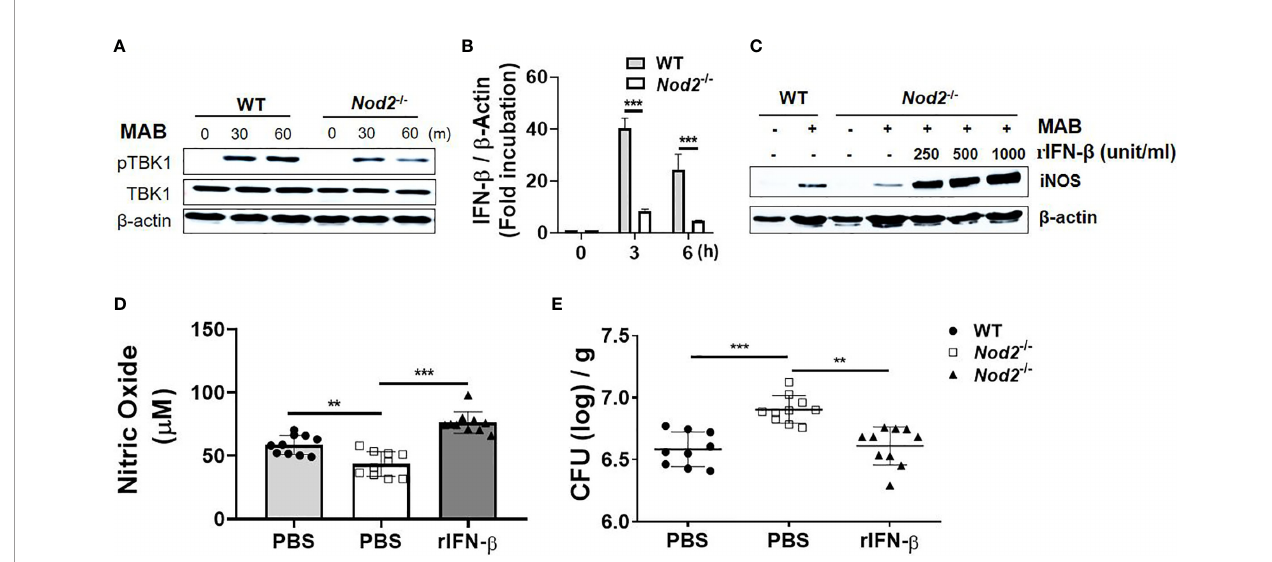
FIGURE 6 | Type I IFNs act as an intermediator of a cytosolic receptor NOD2-mediated NO production in response to MAB. (A) BMDMs were infected with MAB for indicated times. Cellular proteins were extracted, and the levels of each protein were determined by Western blotting. (B) BMDMs were infected with MAB for indicated time. mRNA was extracted, and the expression levels of IFN- b gene were determined by real-time PCR. (C) BMDMs were incubated for 24 h with indicated conditions. The levels of each protein were determined by Western blotting. (D) Nitric oxide levels were measured on 1 day post infection in the lung lysate (same conditions with Figure 4 ). (E) The bacterial load in the lung lysate was determined at 5 days post infection. (A – C) The results are from one representative experiment of two independent experiments. (D, E) The results are merged data of two independent experiments (n = 5) (**p < 0.01, ***p < 0.001). MAB, Mycobacterium abscessus ; IFN, interferon; BMDMs, bone marrow-derived